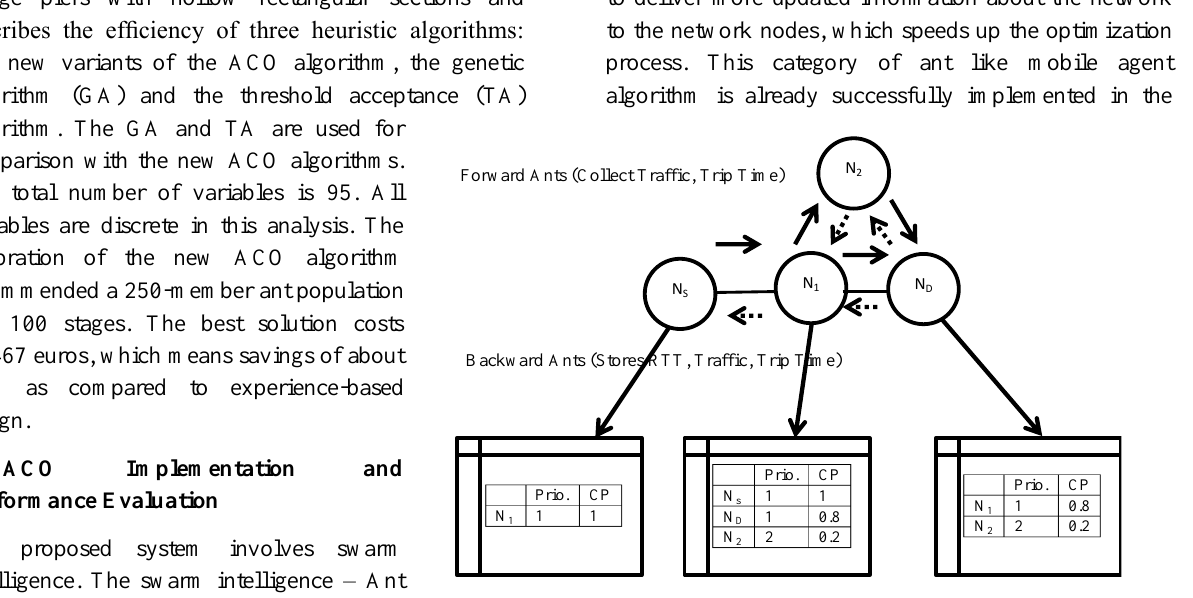
Fig 4: Flow Diagram of Ants movement and Functionality in the Proposed